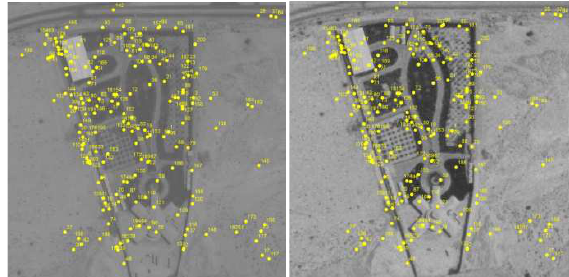
Figure 5. Tie point distribution in agricultural area; IKONOS Imagery (left); orthophoto (right)